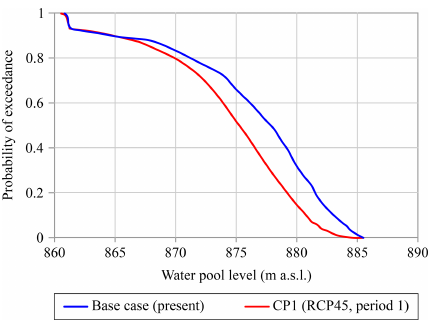
Figure 10. Relation between water pool level and probability of ex- ceedance for the base case (present situation) and the climate pro- jection CP1 (RCP45 and period 1), for the summer